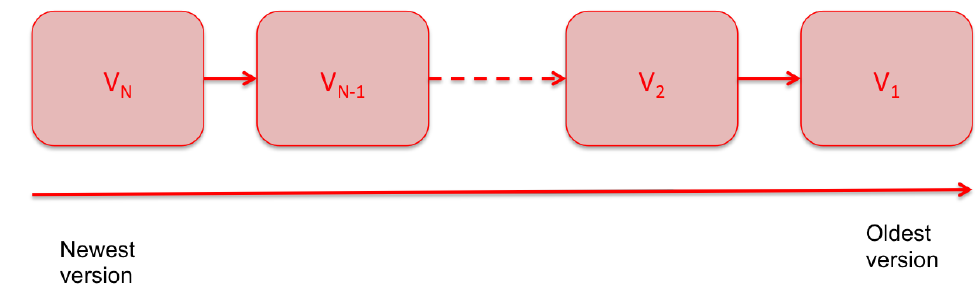
Figure 3. Keeping track of file version history based on link concept.